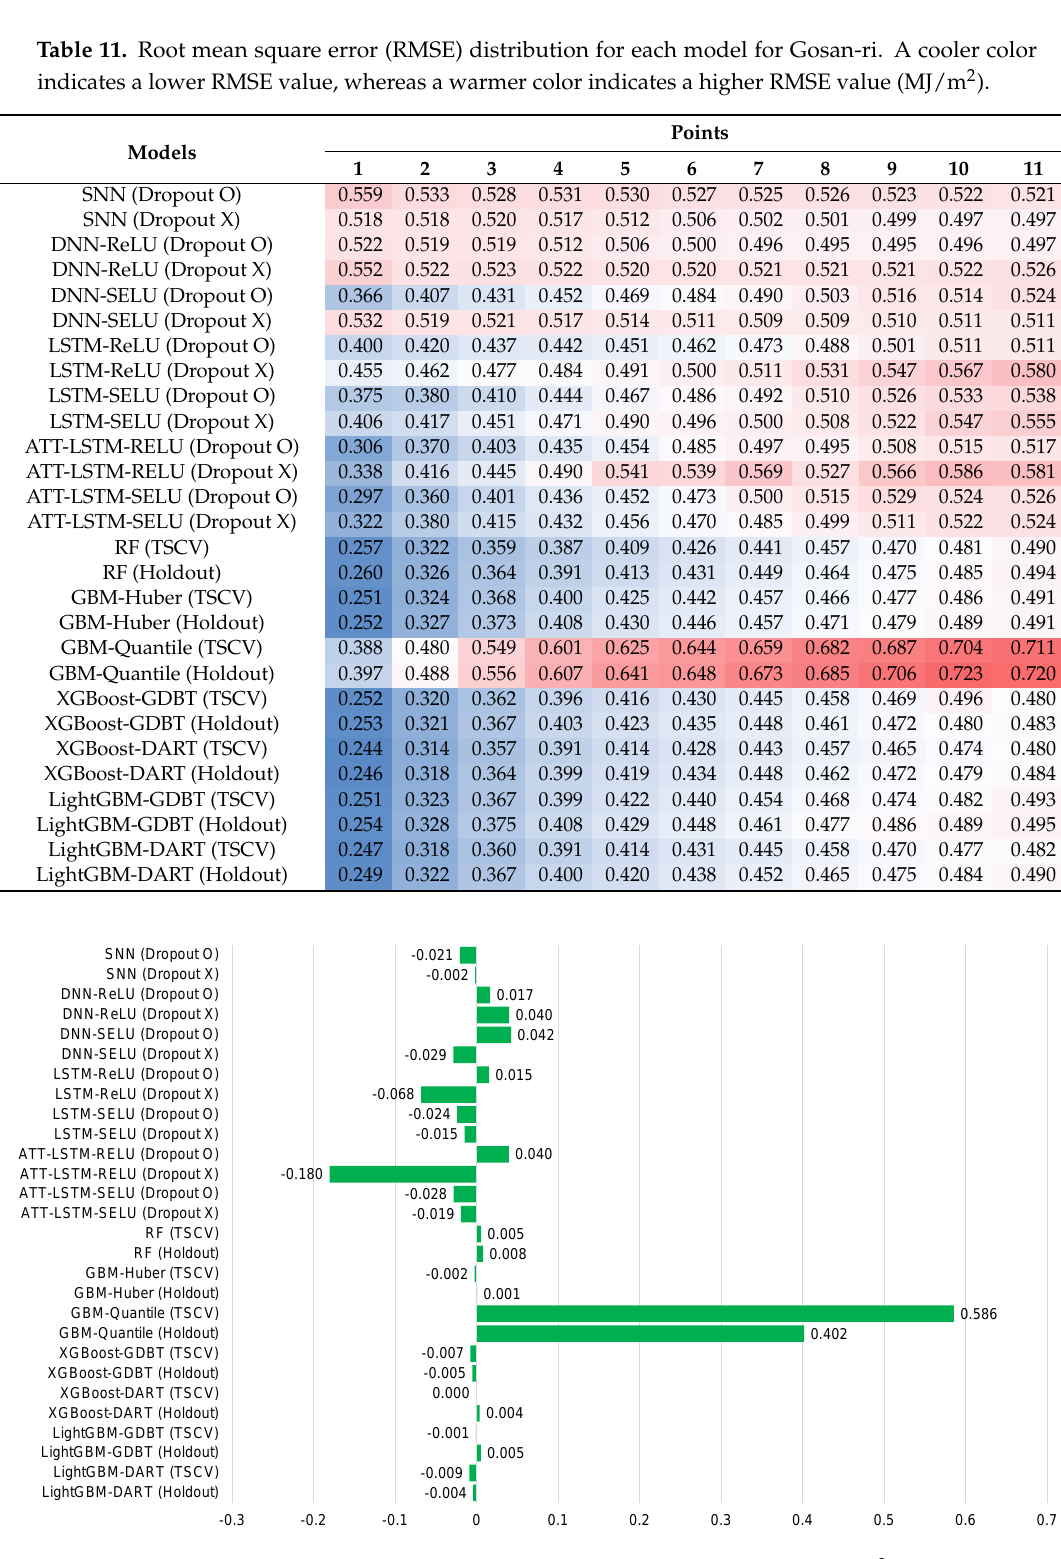
Figure 10. Average mean bias error for each model for Gosan-ri ( MJ/m ).